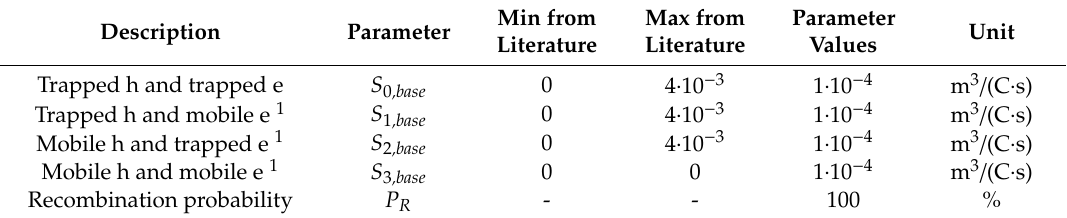
Table 5. Recombination parameter range from publications [3–11] and used recombination parameters in this model.